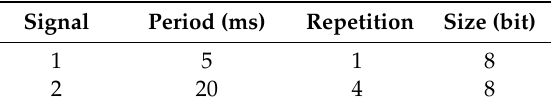
Table 1. Signal message of